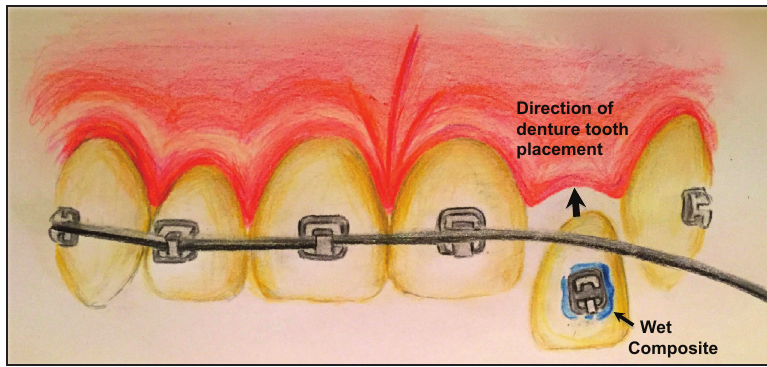
Figure 1. The denture tooth carrying the unset bracket is carefully manoeuvred behind the loosely ligated archwire. The emphasis is on aesthetic placement of the denture tooth in the edentulous space, without worrying about the bracket position.